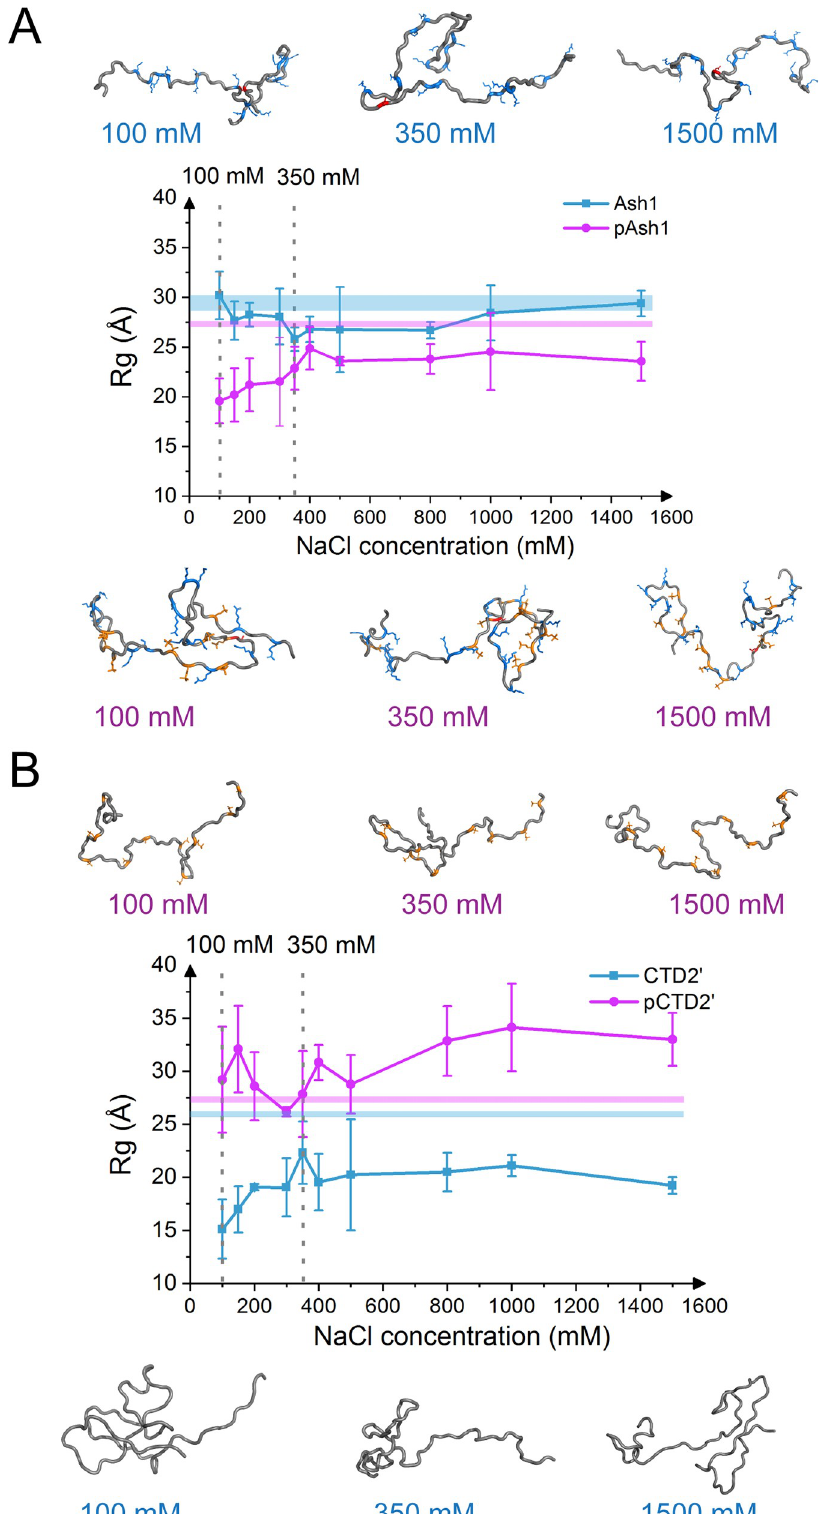
Fig 2. Higher ion strength attenuates phosphorylation-induced shrinkage of Ash1 and expansion of CTD2’. Global conformation changes, measured by Rg, the mass-weighted radius of gyration, of Ash1 (top) and